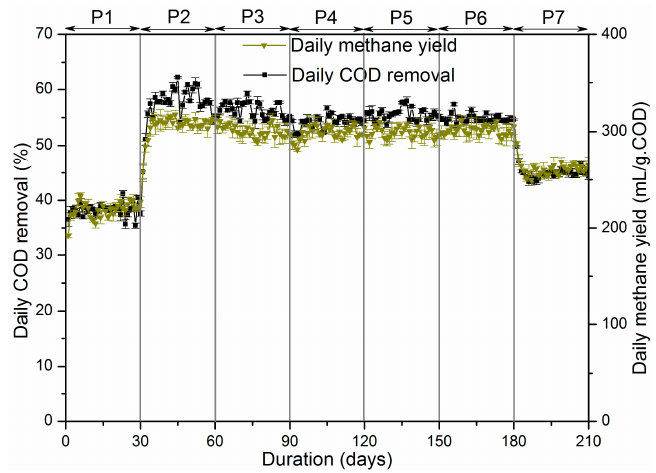
Figure 3. Daily COD removal ( ■ ) and daily methane yield ( ▼ ) under anaerobic and microaerobic conditions during the digestion of sludge (error bars represent standard deviation, n = 3).